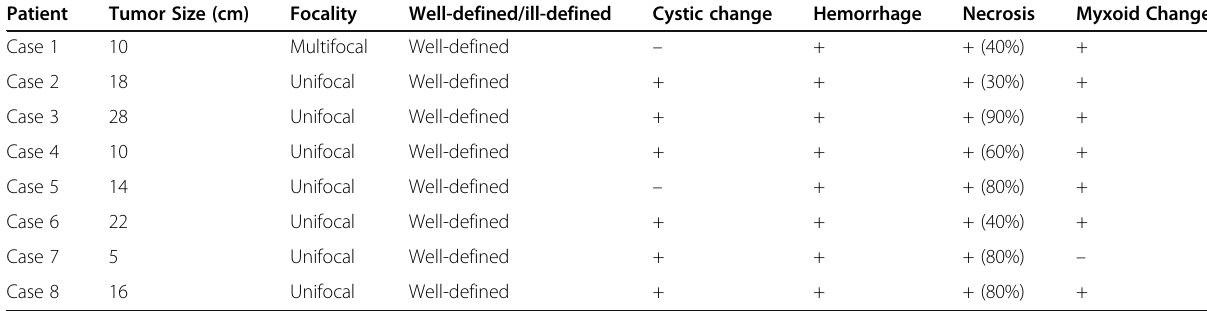
Table 3 Findings on gross examination of UESL